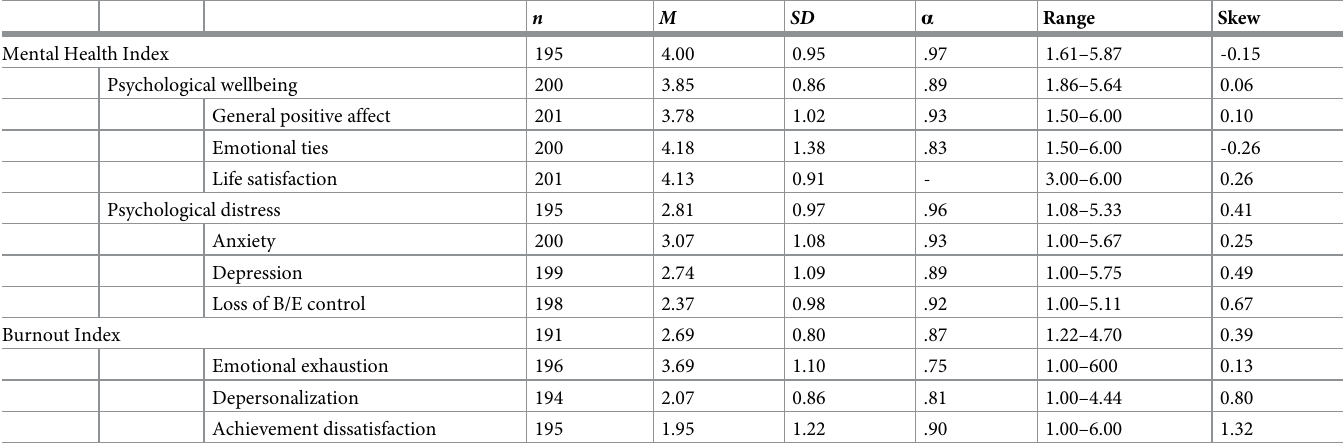
Table 1. Descriptive information for the metric psychological variables.